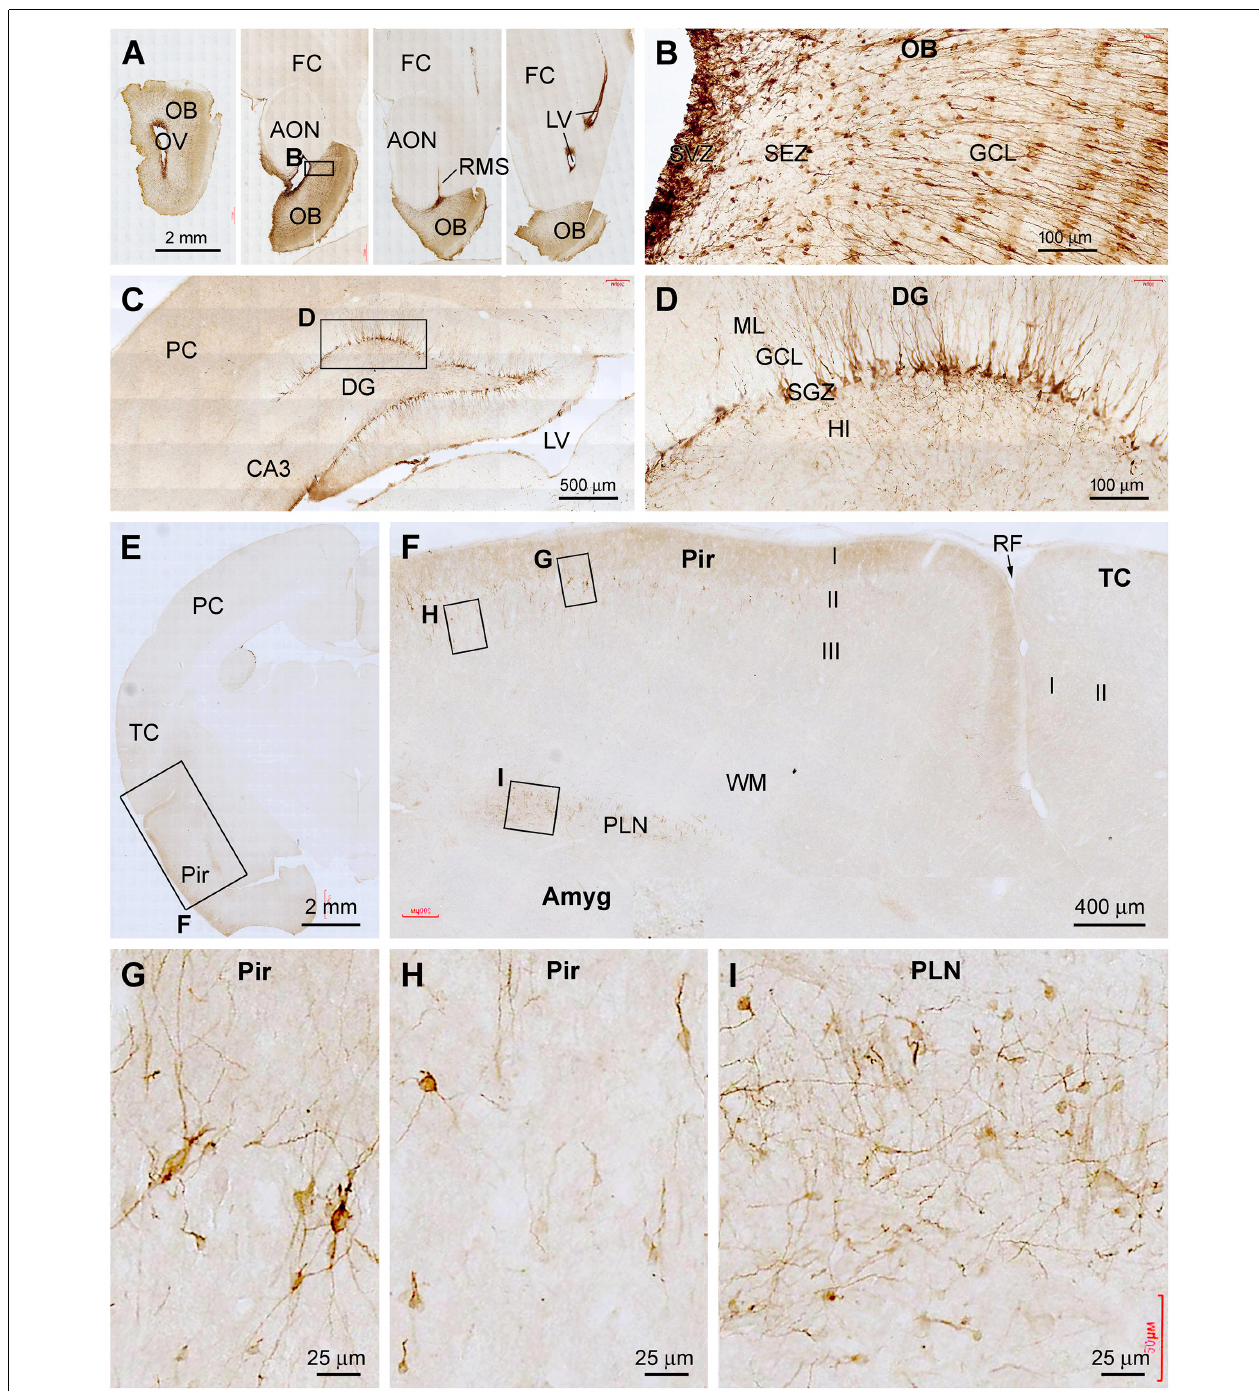
FIGURE 4 | Representative images illustrating DCX+ cellular profiles in the forebrain in a 2 years-old Chinese tree shrew. Panel (A) shows the labeling in the olfactory bulb (OB) and rostral migratory stream (RMS) at four coronal levels, noting the open olfactory ventricle (OV) inside the bulb. Panel (B) shows the labeled cells densely packed at the subventricular zone (SVZ), with migrating granule cells from the subependymal zone (SEZ) to the granule cell layer (GCL). Panel (C) shows labeled cells in the hippocampal dentate gyrus (DG), which are developing granule cells primarily resided along the subgranular zone (SGZ) (D) . Panels (E,F) show DCX+ immature neurons localized selectively in the piriform cortex (Pir) over layer II, but not in the adjoining temporal neocortex. Panels (G–I) show high power views of DCX+ neurons in the piriform cortex and amygdala (Amyg), which are remarkably heterogeneous in somal size, shape, and labeling intensity. Other abbreviations are as defined in Figures 1 – 3 . Scale bars are as